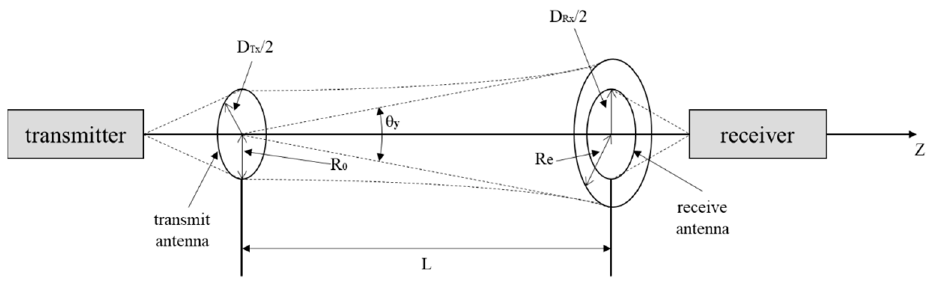
Figure 5. Inter-satellite terahertz communication link structure diagram.